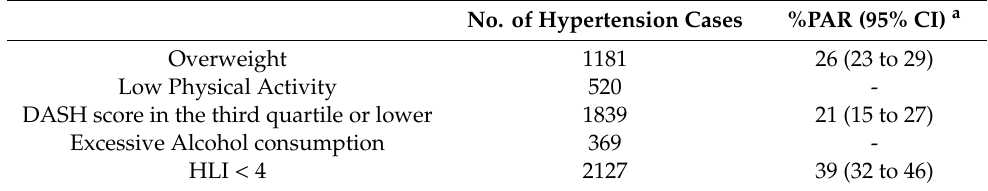
DASH score in the third quartile or lower Excessive Alcohol consumption HLI <